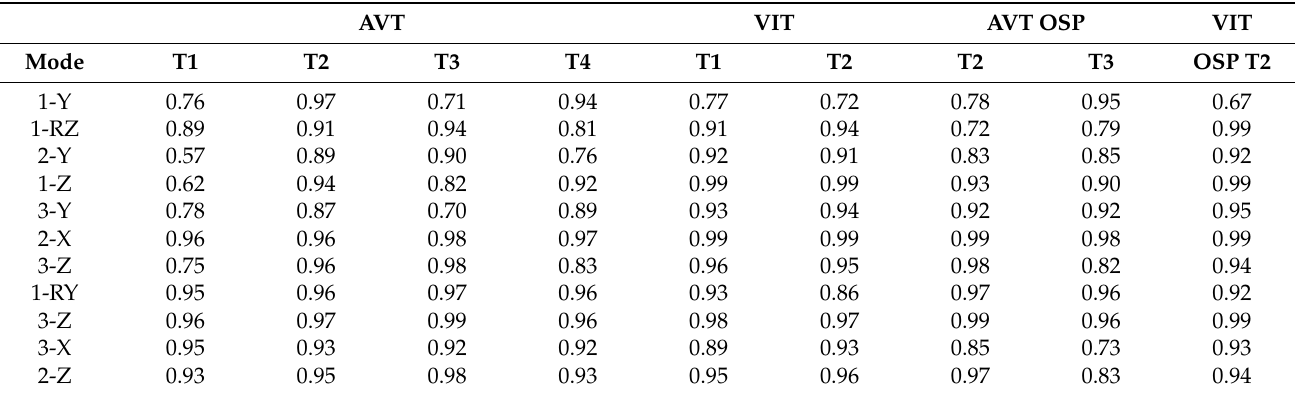
Figure 15. The power spectrum for AVTs and VITs (Units: [m/s 2 ] 2 /Hz). Table 2. Average values of MAC indices of the 11 identified mode